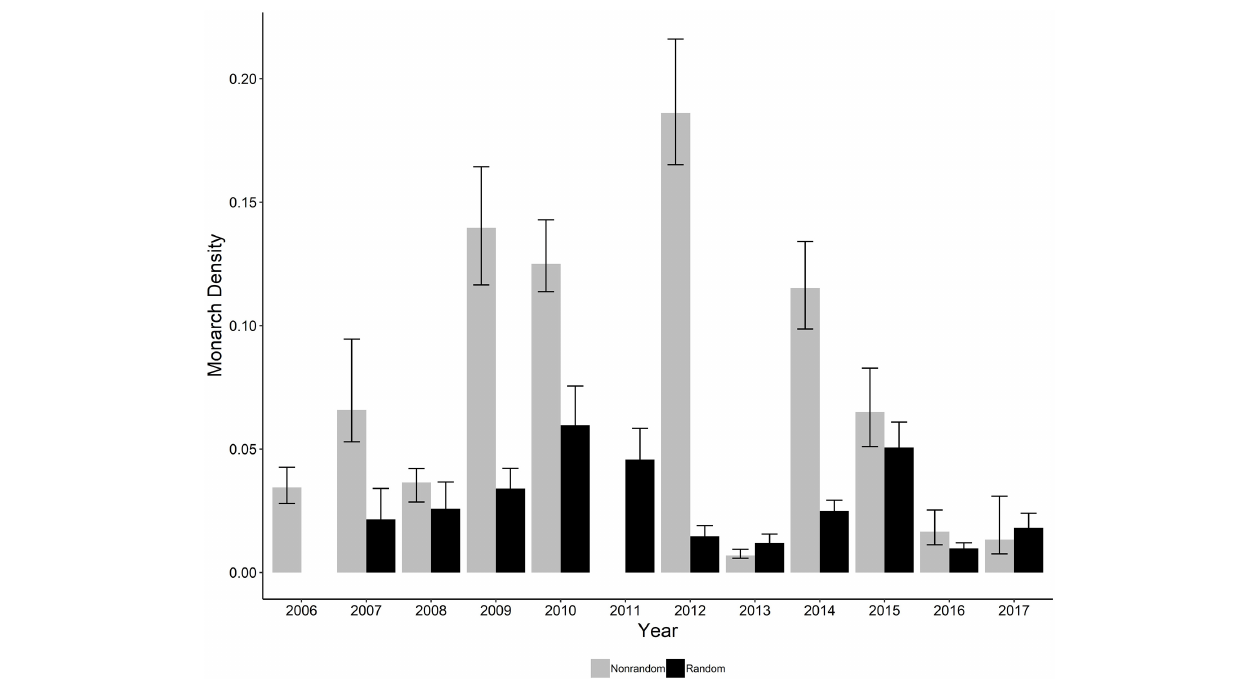
FIGURE 3 | Estimated density per 50-m 2 (95% CI) of monarchs on both random and non-random transects surveyed in Iowa by year, 2006-2017. No random sites were surveyed in 2006 and no non-random sites were surveyed in